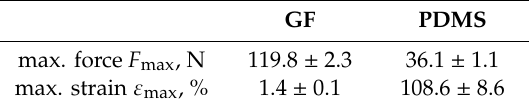
Table 1. Results for single component tests on GF and